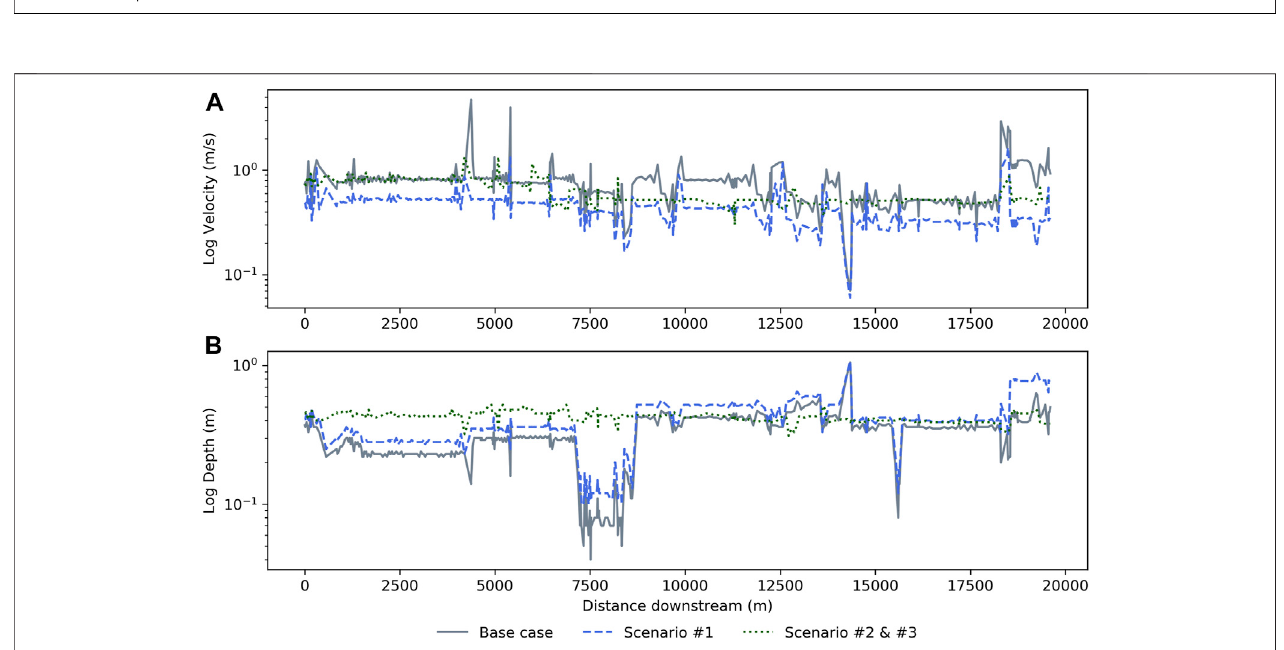
FIGURE3 | Variation of thecross-sectional velocity (A) and depth (B) in the basecase condition and under determinedmanagement scenarios. The y -axis in both panels is in log format.